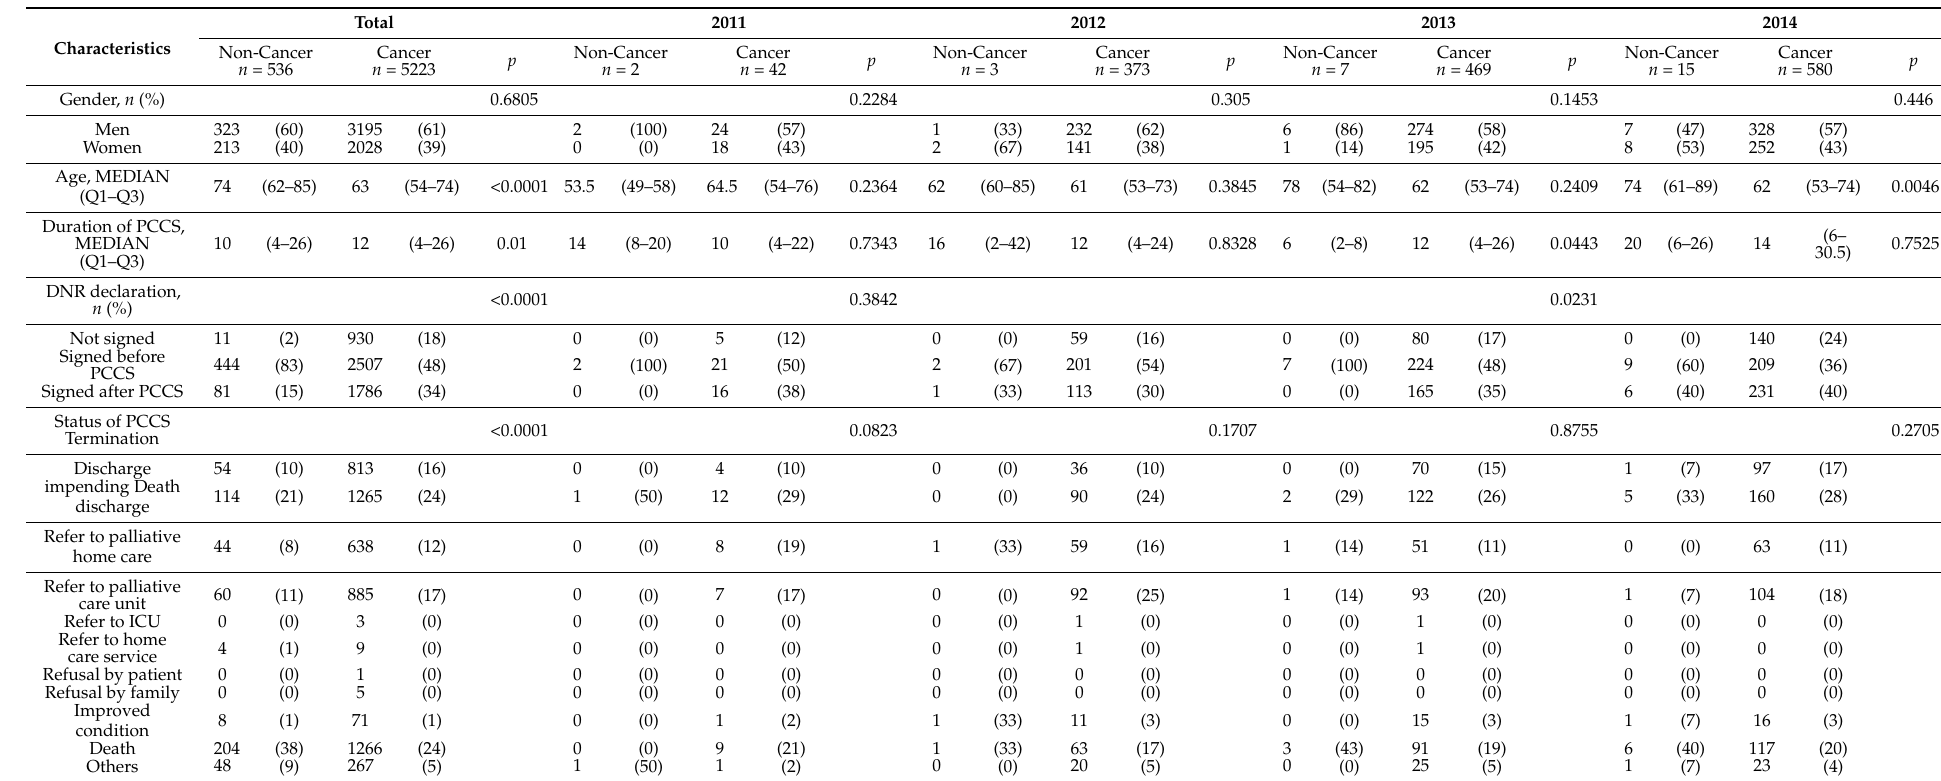
Table 1. Characteristics of terminally ill non-cancer patients receiving PCCS from 2011 to